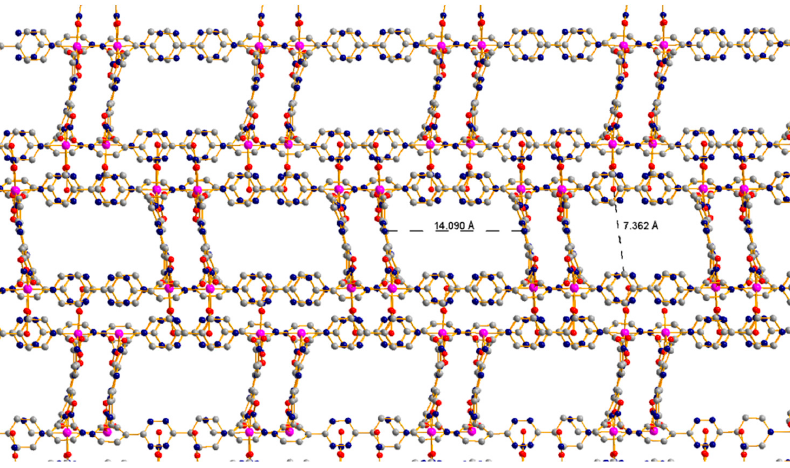
Figure 4. Co-pytz (isostructural to Ni(pytz)) view along a-axis; pore window sizes determined for DCM inclusion. DCM and ligand H atoms omitted from image for clarity. Co ( purple ), C ( grey ), N ( blue ), O ( red ).